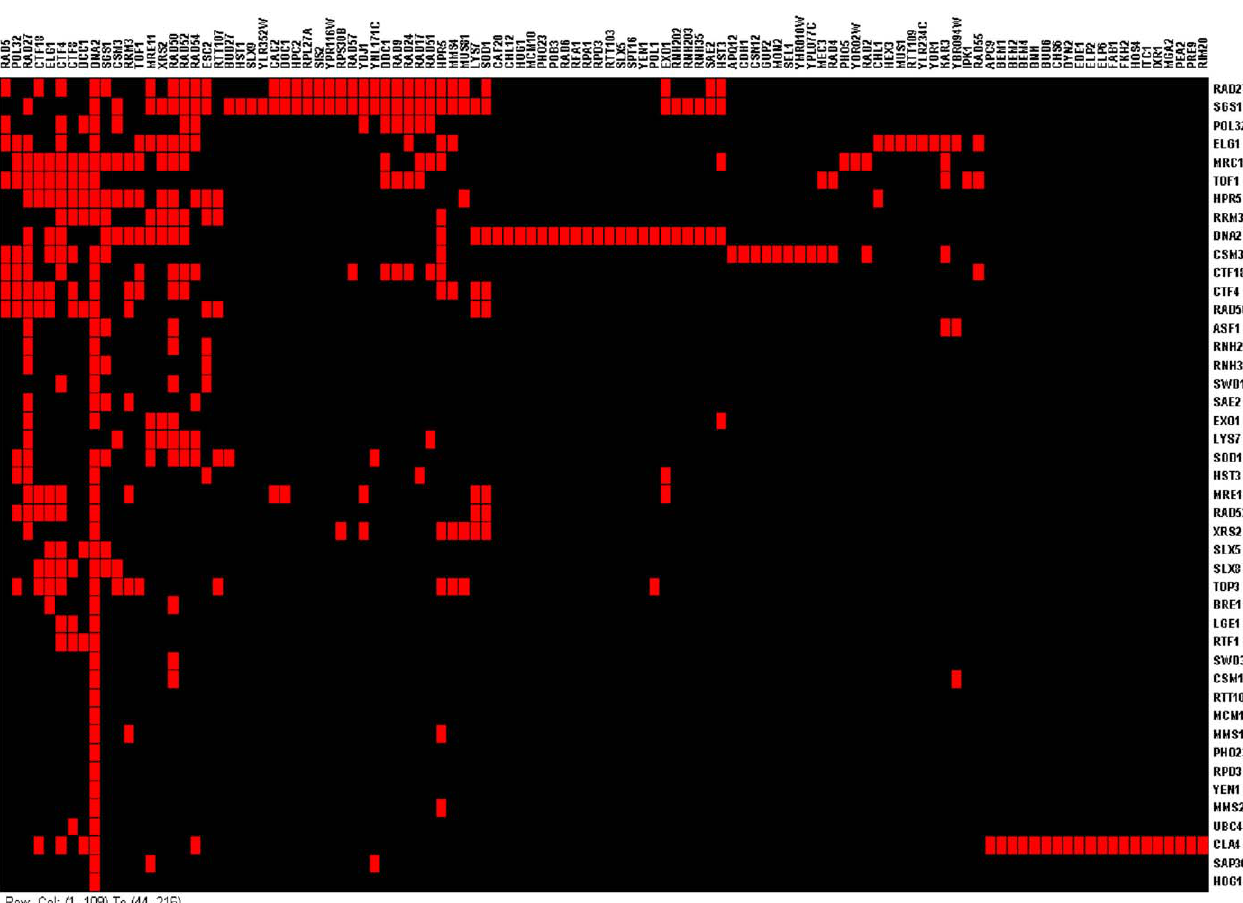
Figure 1. Clustering Analysis Hierarchical two-dimensional clustering analysis was applied to the DNA2 interactions and those of 43 genes synthetically lethal with DNA2 (see Table 1). The interactions were clustered with respect to the results of the current screen and 43 previous screens using these genes as queries. A total of 322 genes and 876 interactions, each indicated by a red box, were identified. This panel shows a zoom into the region of most significant overlap of shared genetic interactions. In addition to including reduced fitness genes, this analysis includes genes that give increased fitness with dna2, such as pol32 D . DOI: